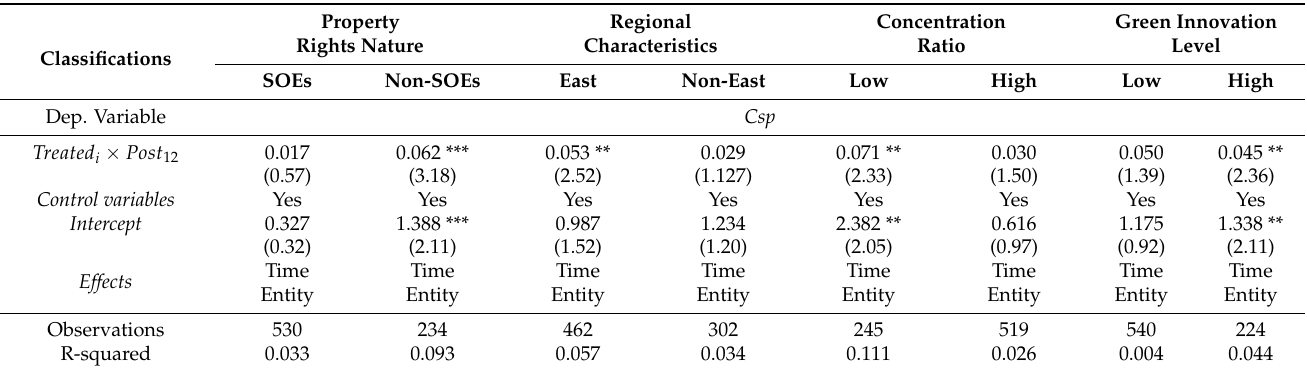
Table 6. Results of the heterogeneity